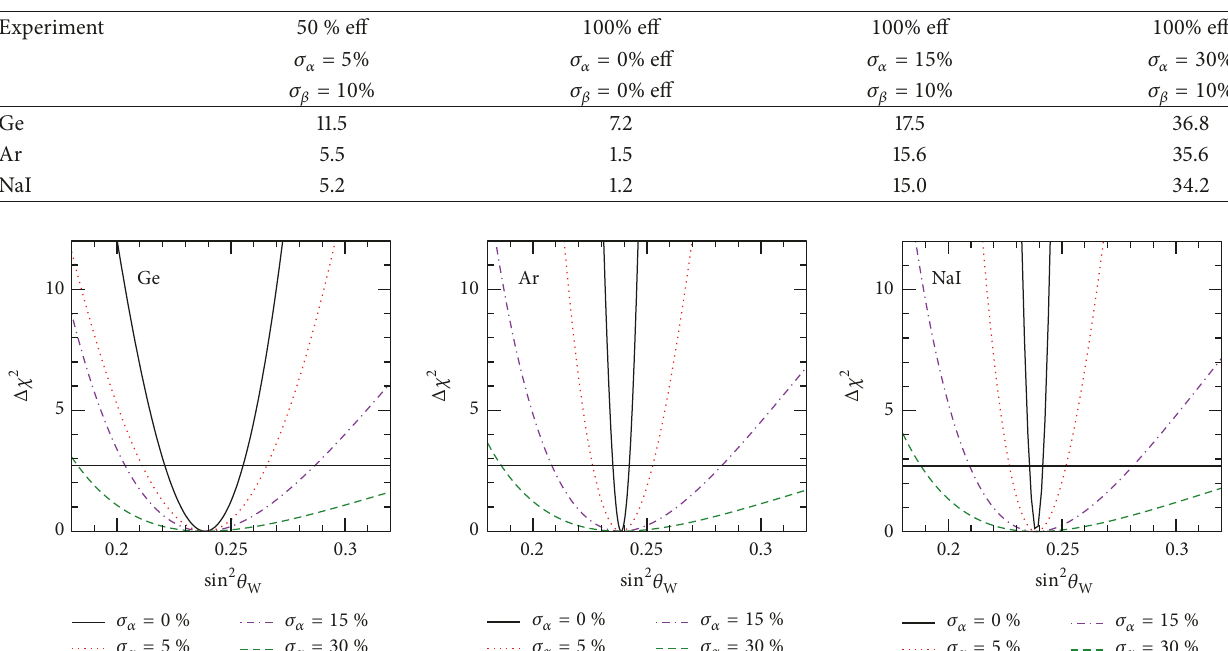
Table2:Expectedsensitivity,inpercent,totheweakmixingangle.Foreachexperimentweshowthe90%expectedsensitivityforthedifferent cases that we have considered.